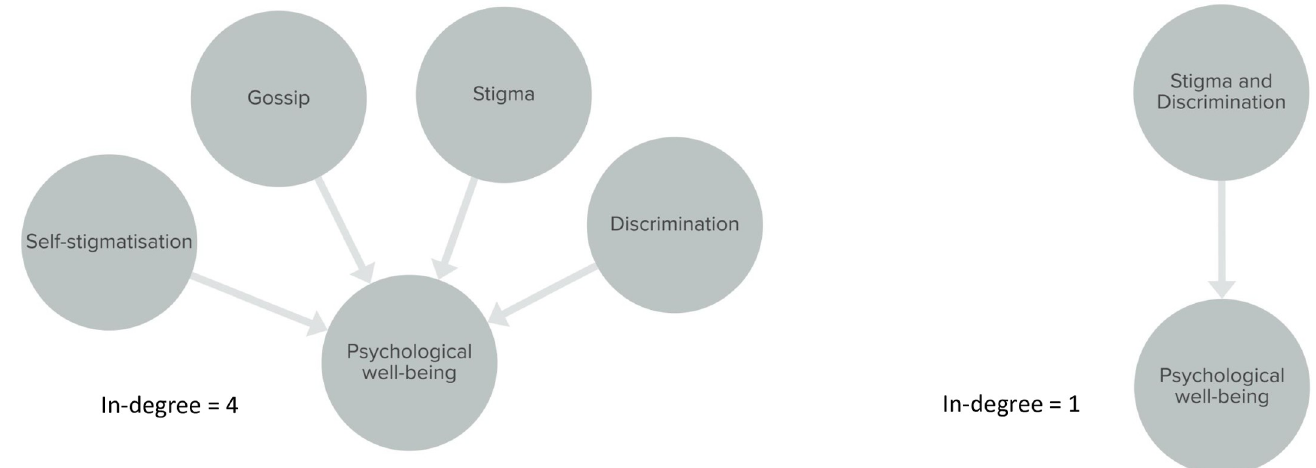
Fig 5. In-degree. Illustration of mapping choices to be made by the researchers and the consequences for the in-degree metric.